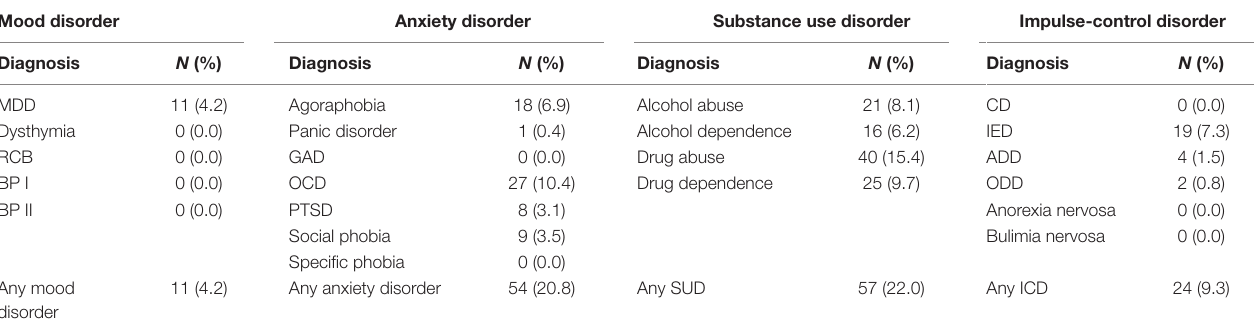
TaBle 2 | 12-month Prevalence rates of DsM-iV mental disorders. Mood disorder anxiety disorder substance use disorder impulse-control